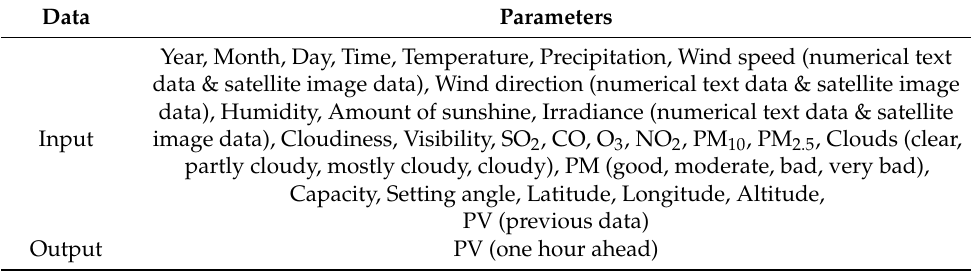
Table 12. The parameters of the solar PV generation prediction